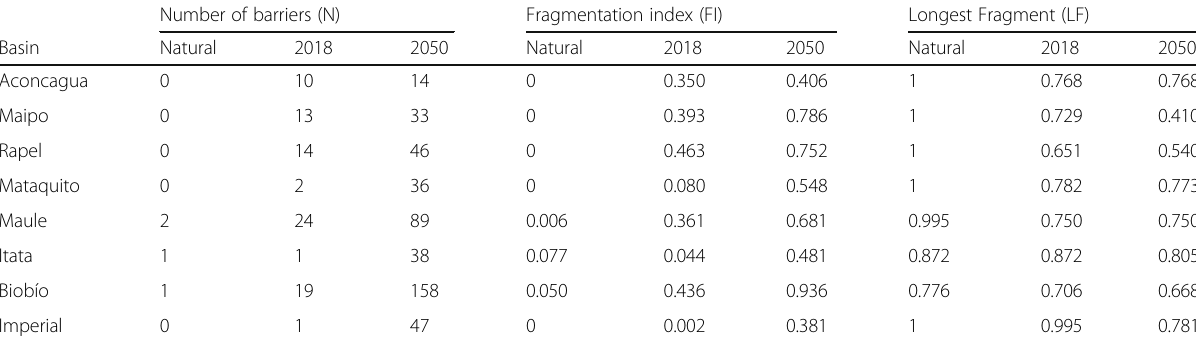
Table 3 Metrics of fragmentation for each of the studied river network in the three analysed scenarios Number of barriers (N)